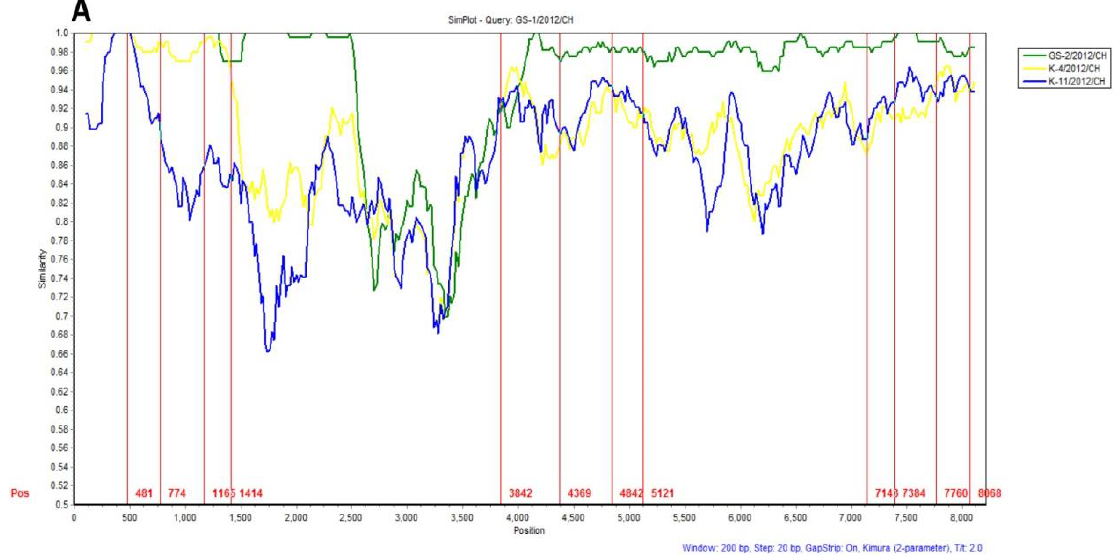
Figure 1. Nucleotide similarities and recombination among the kobuvirus